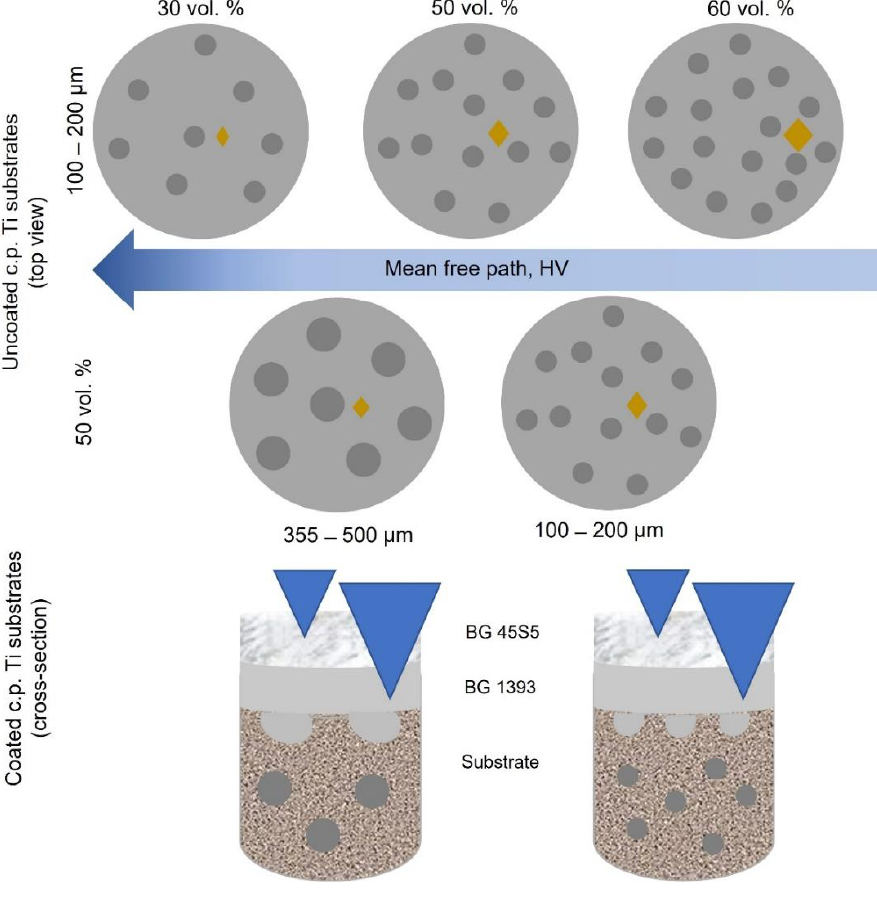
Figure 6. Estimated HV and Young ’ s modulus from the P-h curves.